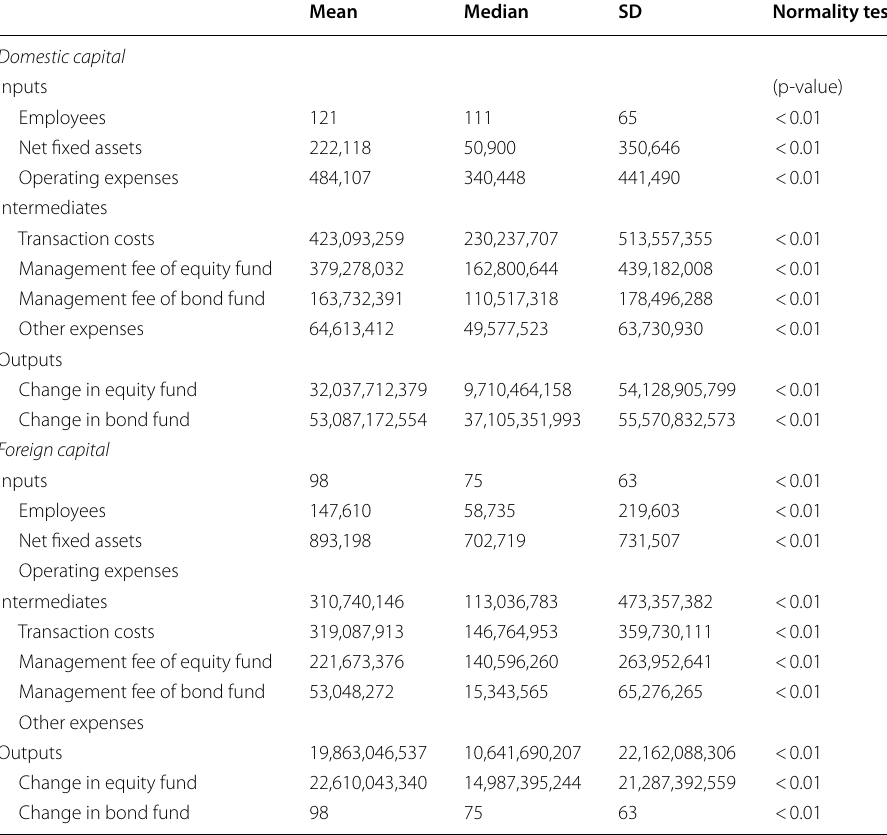
Table 3 Descriptive statistics of inputs, intermediates, and outputs (n